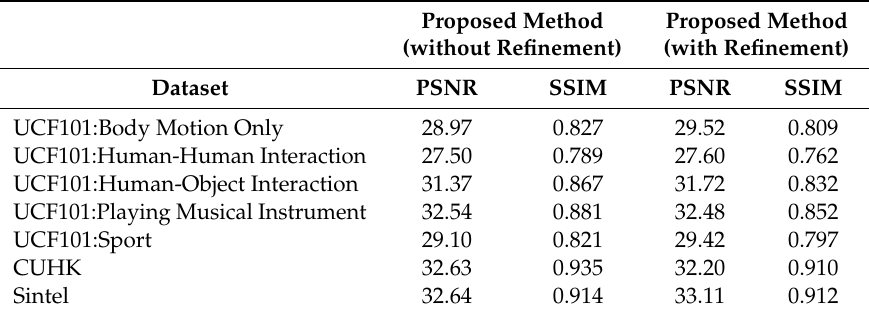
Table 5. Objective evaluation on various datasets for the proposed